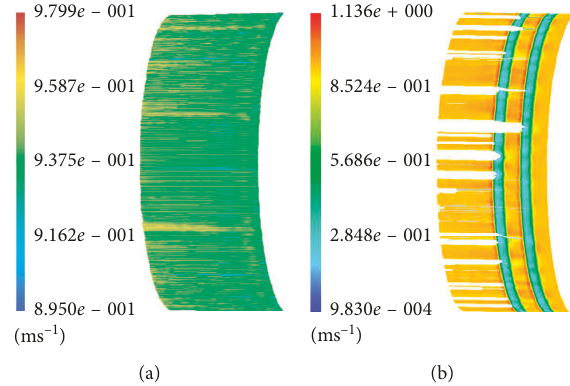
Figure 12: Piston surface leakage streamline: (a) standard piston; (b) bionic